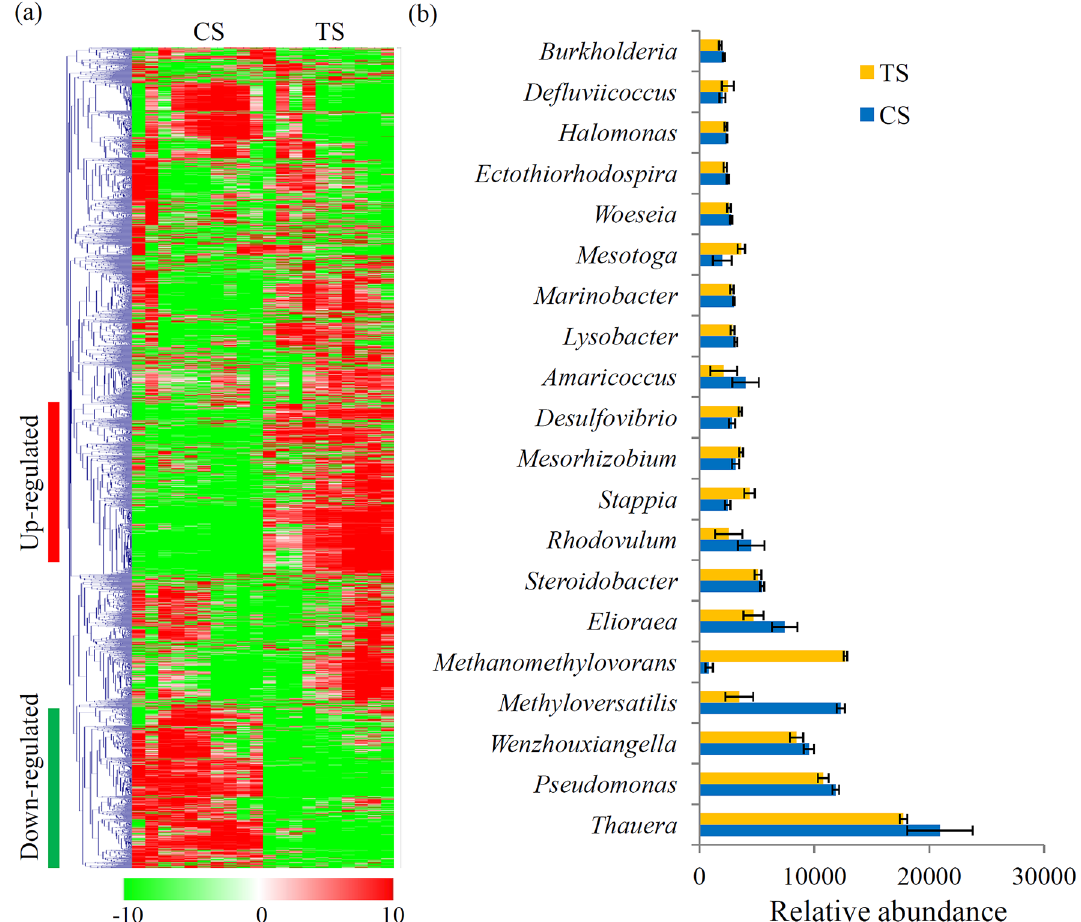
Figure 1. Comparative taxonomic profile of CS and TS metagenomes. ( a ) Microbial compositions for both CS and TS sample groups at genus level. Color intensity in each panel shows the relative abundances of each representative genus in the CS and TS sample groups. The heatmap scale ranges from − 10 to + 10 on a log 2 scale. ( b ) Microbial compositions for both CS and TS sample groups at genus